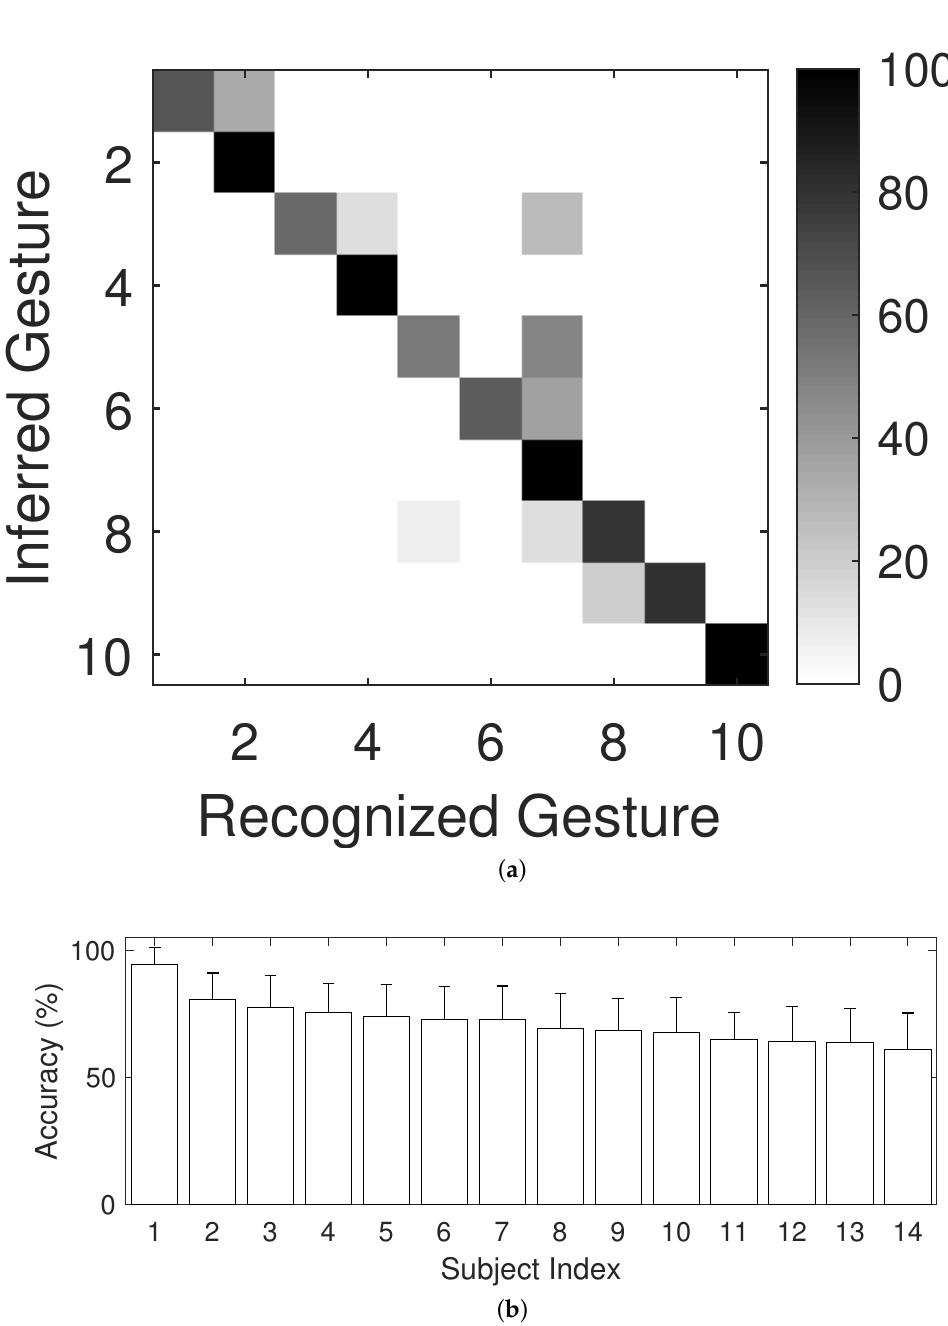
Figure 5. Classification result of raw data. ( a ) Confusion matrix of subject two. ( b ) Average accuracy of 14